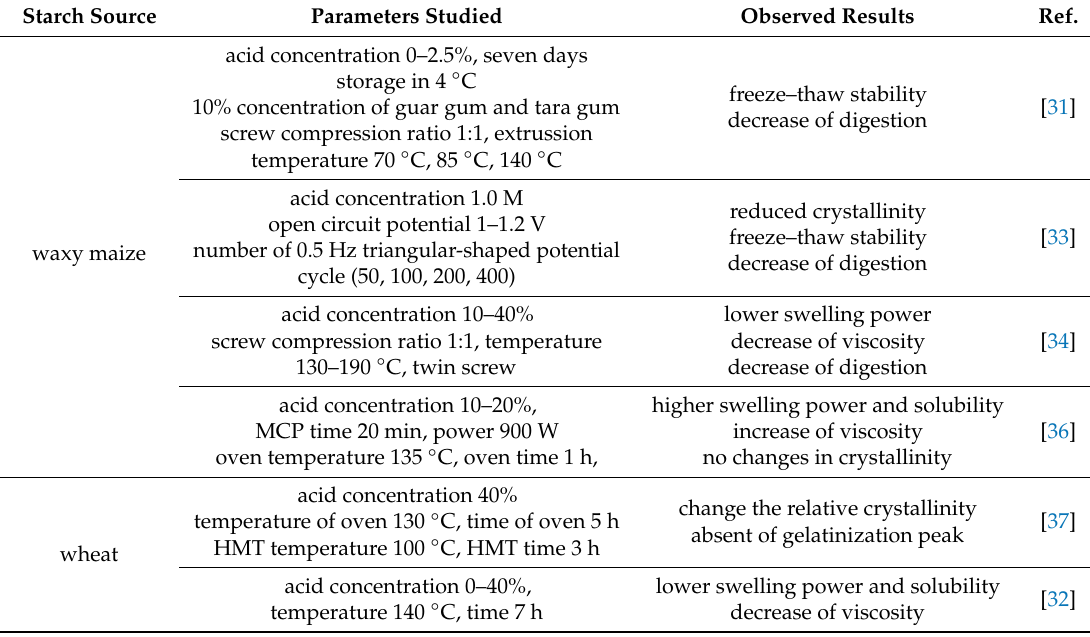
Table 2. Properties of starch citric